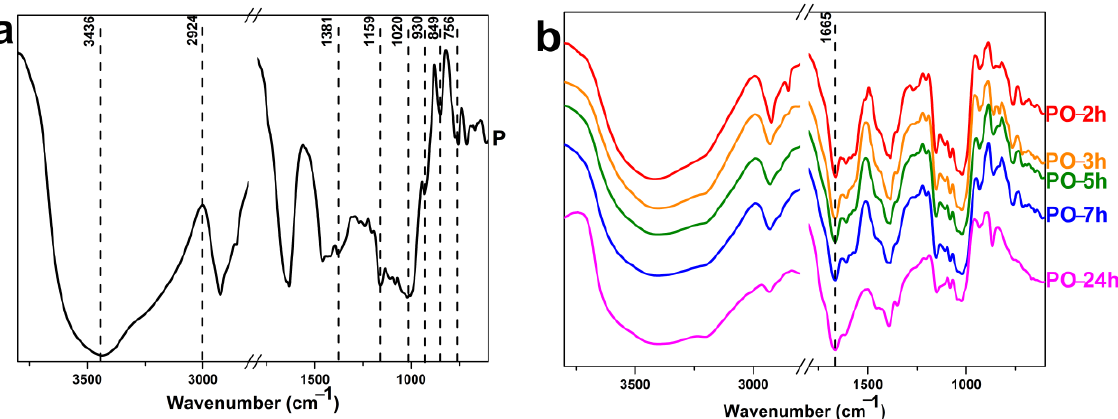
Figure 7. ( a ) FTIR spectrum of pullulan (P). ( b ) FTIR spectra of oxidized pullulan (PO) in the presence of an H 2 O 2 /NHPI system.